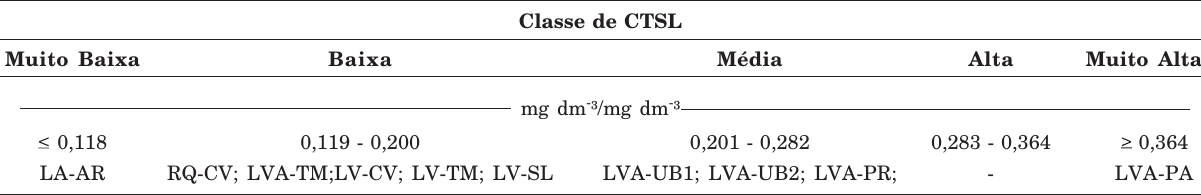
Quadro 6. Coeficientes de correlação linear simples entre a CTSL e algumas características químicas, físicas, físico-químicas e mineralógicas dos 10 solos, em diferentes tempos de incubação